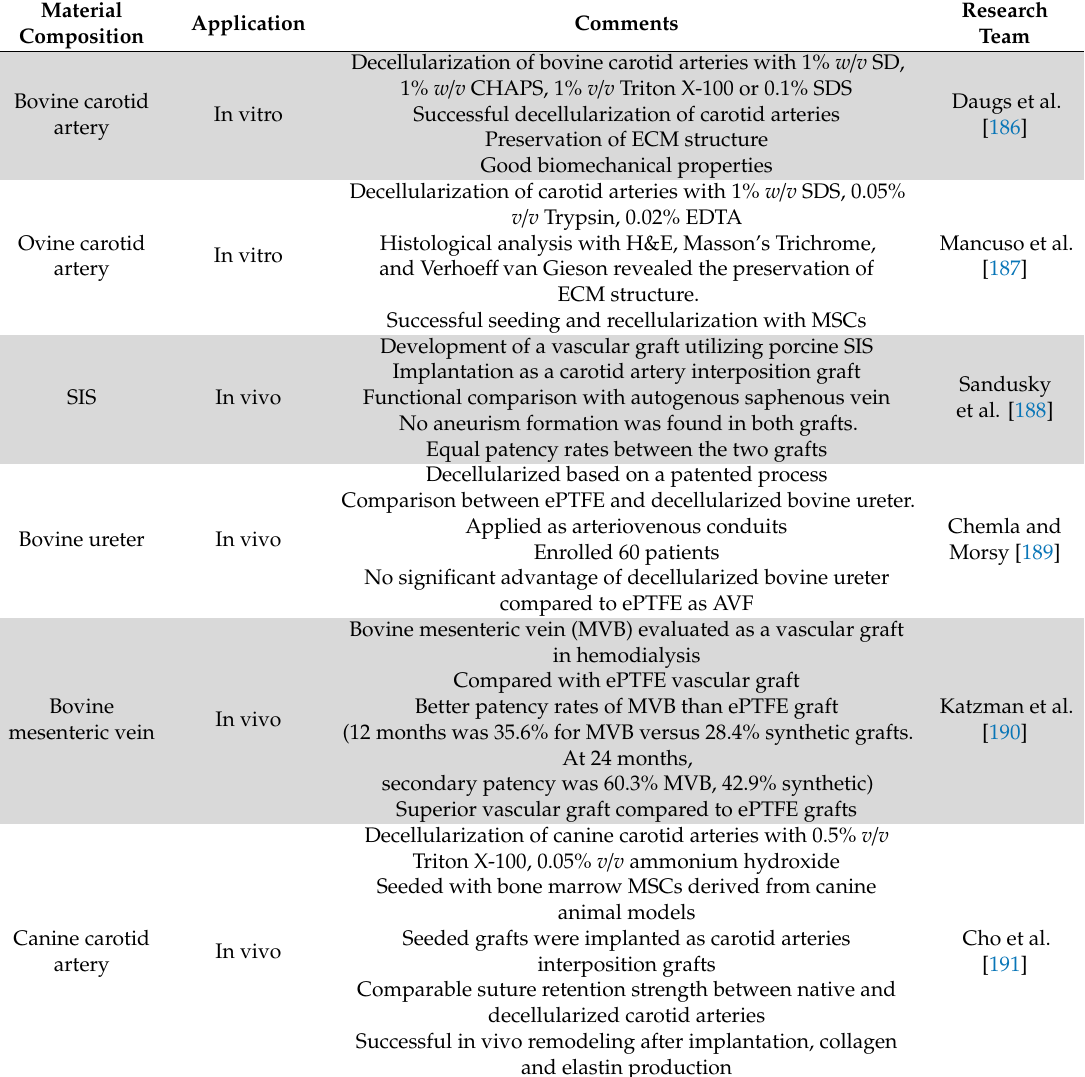
Table 5. Summary of representative studies toward decellularized animal-derived vascular